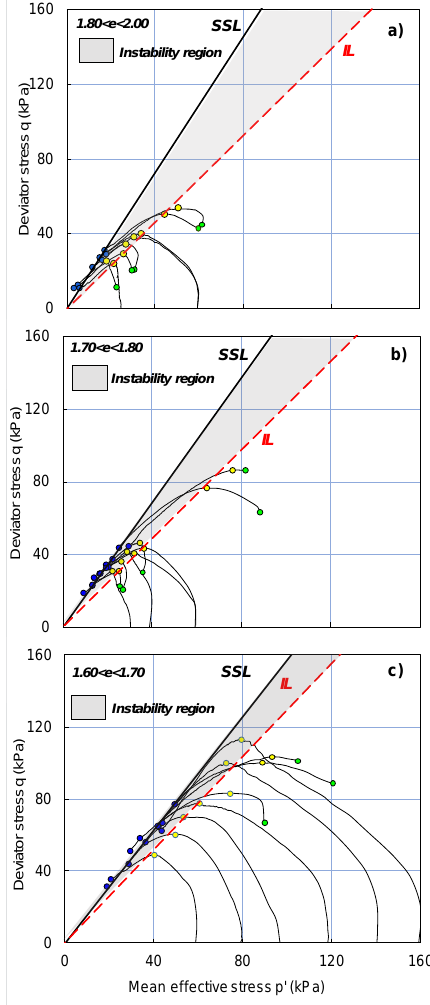
Figure 6. Stress paths of triaxial compression tests on anisotropically consolidated specimens (CAU_c) and CIU_c tests having void ratios ranging between: ( a ) 1.8–2.0; ( b ) 1.7–1.8; ( c ) 1.6–1.7.